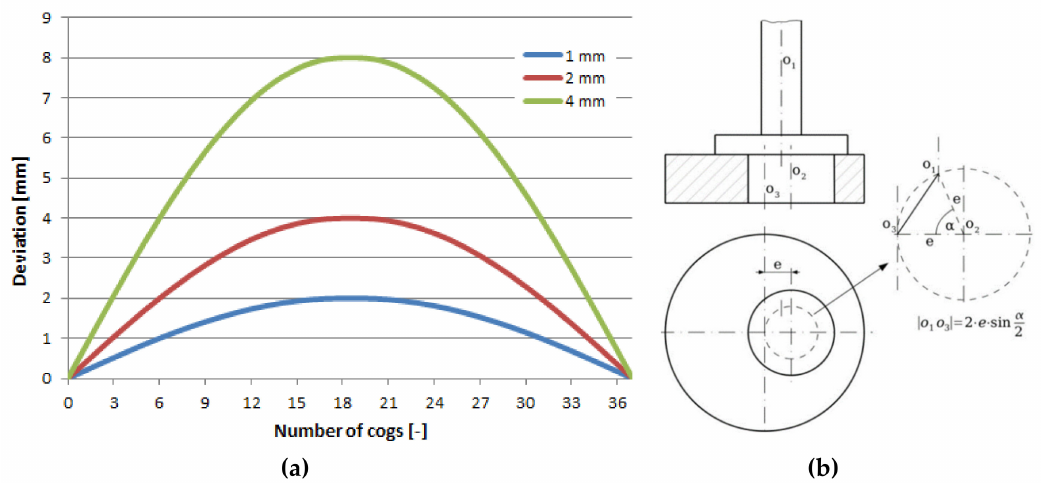
Figure 11. ( a ) The functions of the deviations selected by the eccentric couple through mutual rotation by the corresponding number of cogs from the zero eccentricity value up to the maximal eccentricity, e = 1, 2 and 4 mm; ( b ) the scheme of adjusting the eccentricity